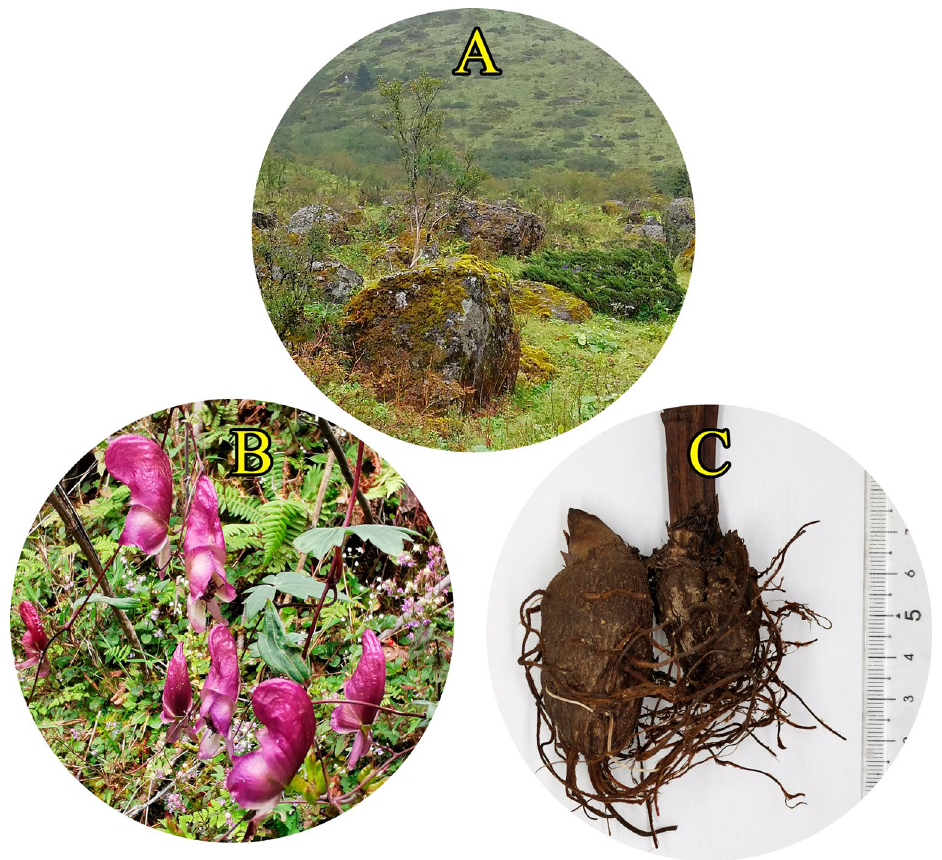
Figure 1. ( A ) The wild habitat of A. ep iscopale. ( B ) Plant of A. episcopale . ( C ) Crude drug from A. episcopale